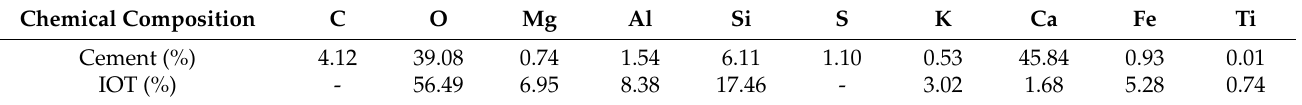
Table 1. Chemical composition of cement and iron tailings.